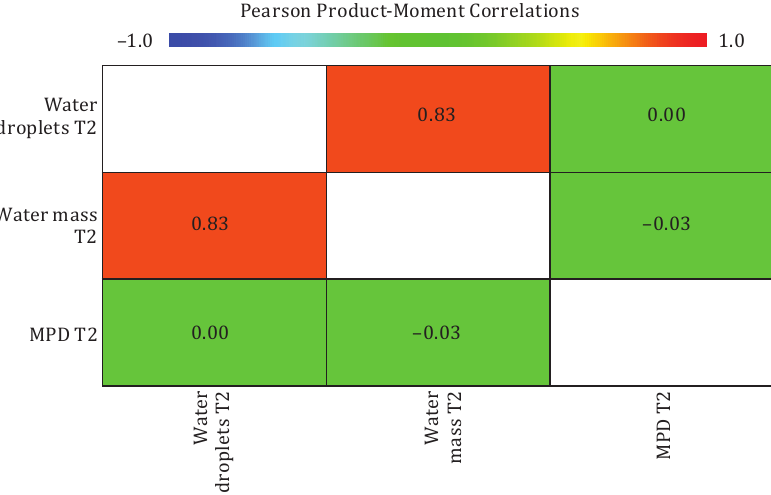
Figure 15. Pearson product-moment correlations between each pair of variables for Test Track